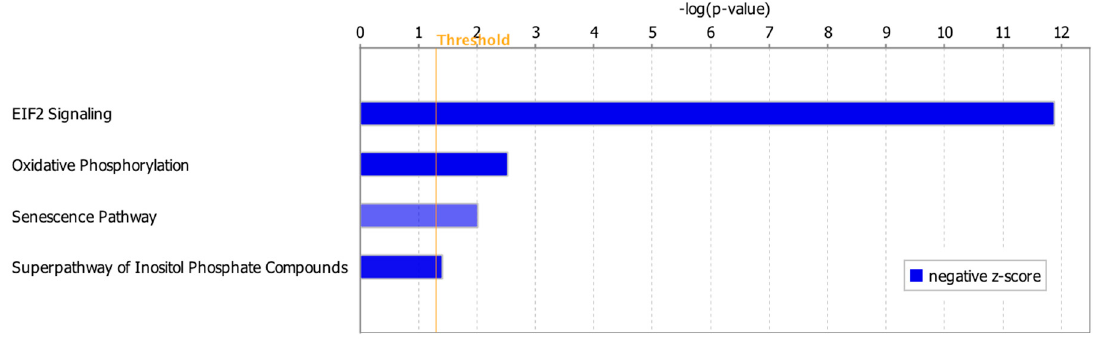
Figure 3. Inhibited canonical pathways in the ICM group. All the inhibited pathways had z -scores smaller than − 2.0 (Supplementary Table S2).